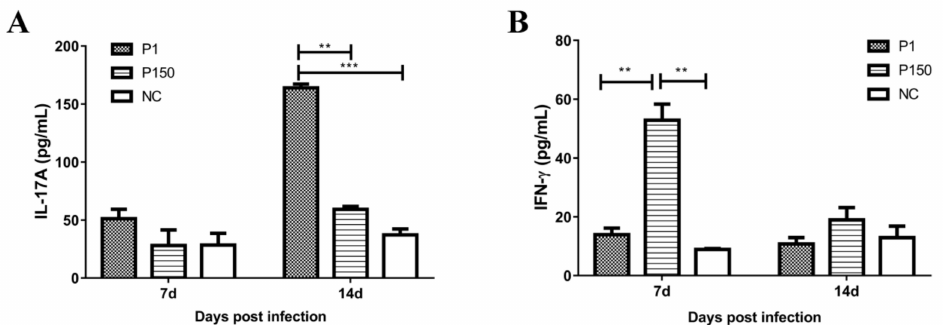
Figure 8. Blood IL-17A ( A ) and IFN- γ ( B ) concentrations in experimental calves. P1 represents as the P1 group, P150 as the P150 group, and NC as the mock-infected group,